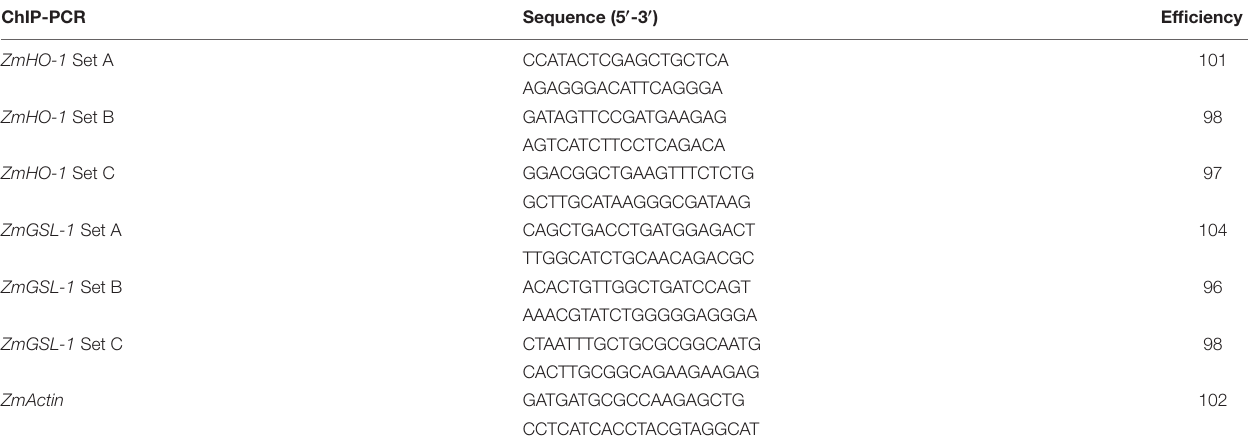
TABLE 2 | Primers used for ChIP-PCR and CHART-PCR. ChIP-PCR Sequence (5 (cid:48) -3 (cid:48) )